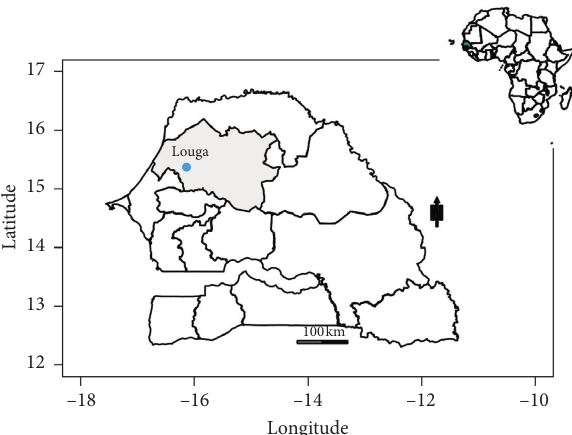
Figure 1: Map showing Louga City in Northwestern Senegal. Construction of the map was done using the maptools package installed in R studio version 1.2.1335; the shapefiles were down- loaded from the free domain of the Geographic Information System